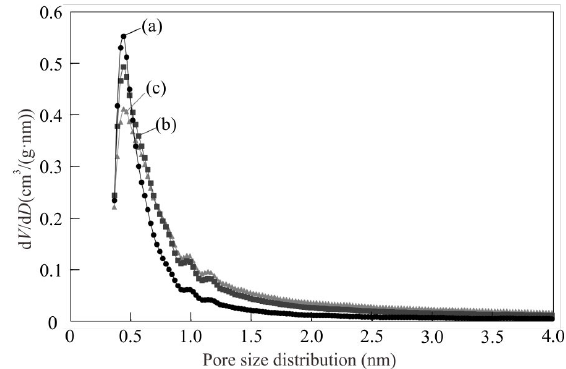
Fig. 6 Pore size distribution of the hollow silica–alumina composite spheres prepared using (a) 40, (b) 80, and (c) 120 g of the PS suspension, calculated using the SF method.